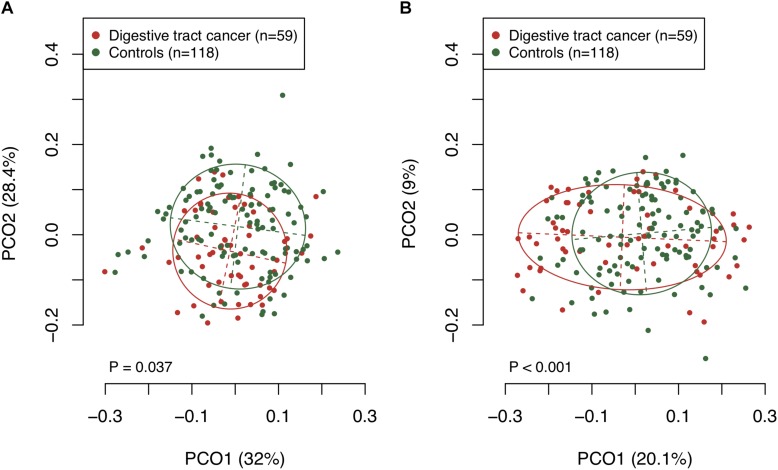
Principal coordinate analysis based on (A) weighted and (B) unweighted UniFrac distances. The bacterial composition of patients and control subjects are depicted using different colors. These two components explained the 60.4% (A) and 29.1% (B) variances. The intersection of the broken lines indicates the center of gravity for each community type. The ellipse covers 67% of the samples belonging to each community type. The P-value was calculated by the analysis of similarities (ANOSIM).